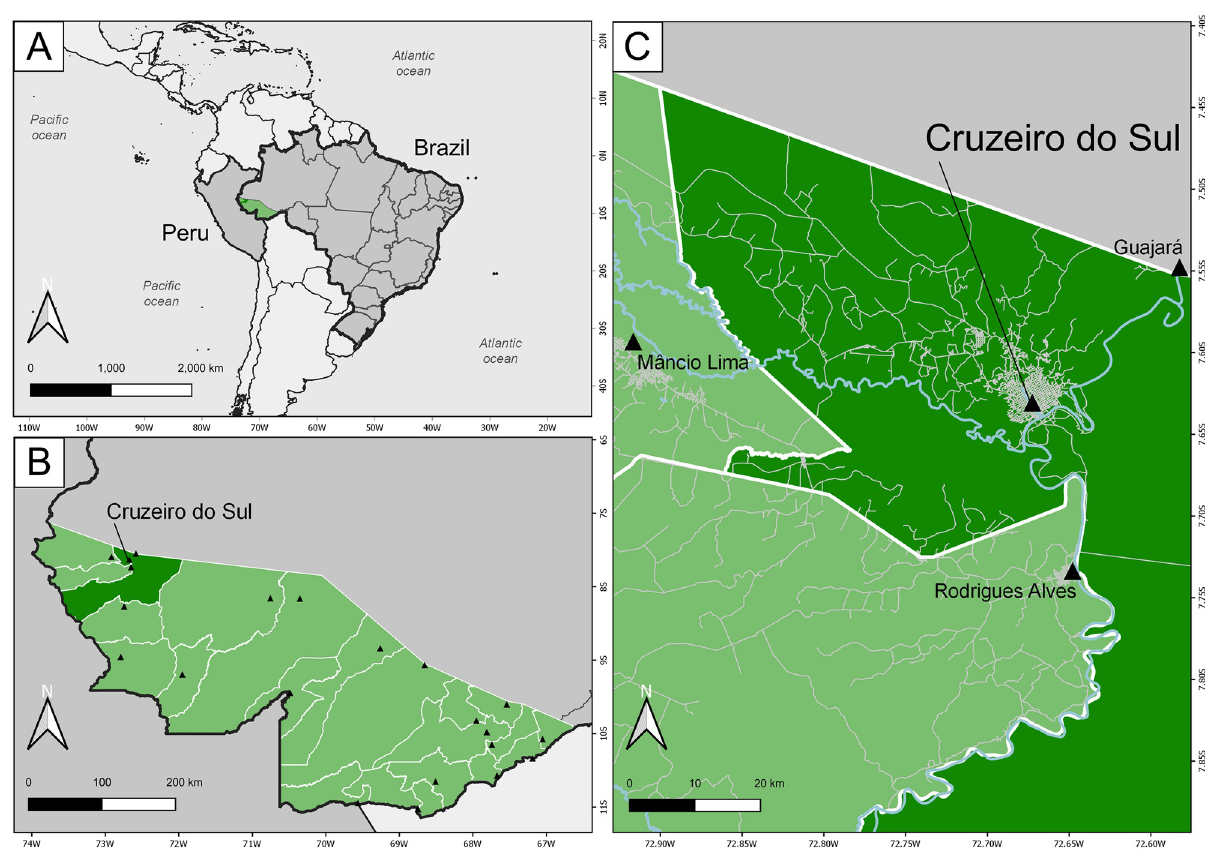
Fig 1. Study site. The map shows Brazil and Peru in South America (panel A) and the location of the municipality of Cruzeiro do Sul (dark green) in the Upper Jurua´ Valley region, Acre State (light green), northwestern Brazil (panel B). The urban area of Cruzeiro do Sul is shown in greater detail in panel C. Other cities and towns in the region (Maˆncio Lima, Guajara´, and Rodrigues Alves) are also indicated by triangles. Roads and streets are represented in light gray. Rivers are represented in blue. Figure created with QGIS software version 3.14, an open source Geographic Information System (GIS) licensed under the GNU General Public License (https://bit.ly/2BSPB2F). Publicly available shape files were obtained from the Brazilian Institute of Geography and Statistics (IBGE) website (https://bit.ly/34gMq0S). Roads, streets, and rivers were obtained from the Open Street Map Foundation website (https://bit.ly/3pzh4xp). All utilized geographical data are under the Creative Commons Attribution License (CC BY